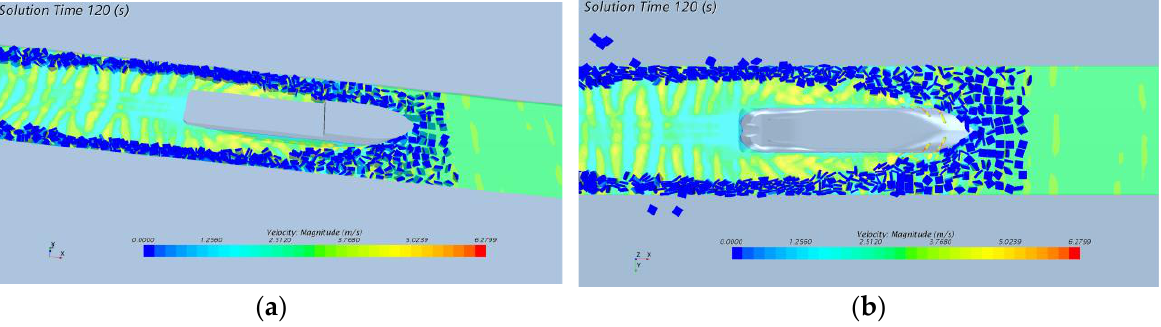
Figure 8. The snapshot at 120 s of the simulation when the air-bubble system has been activated: ( a ) isometric view; ( b ) bottom view.